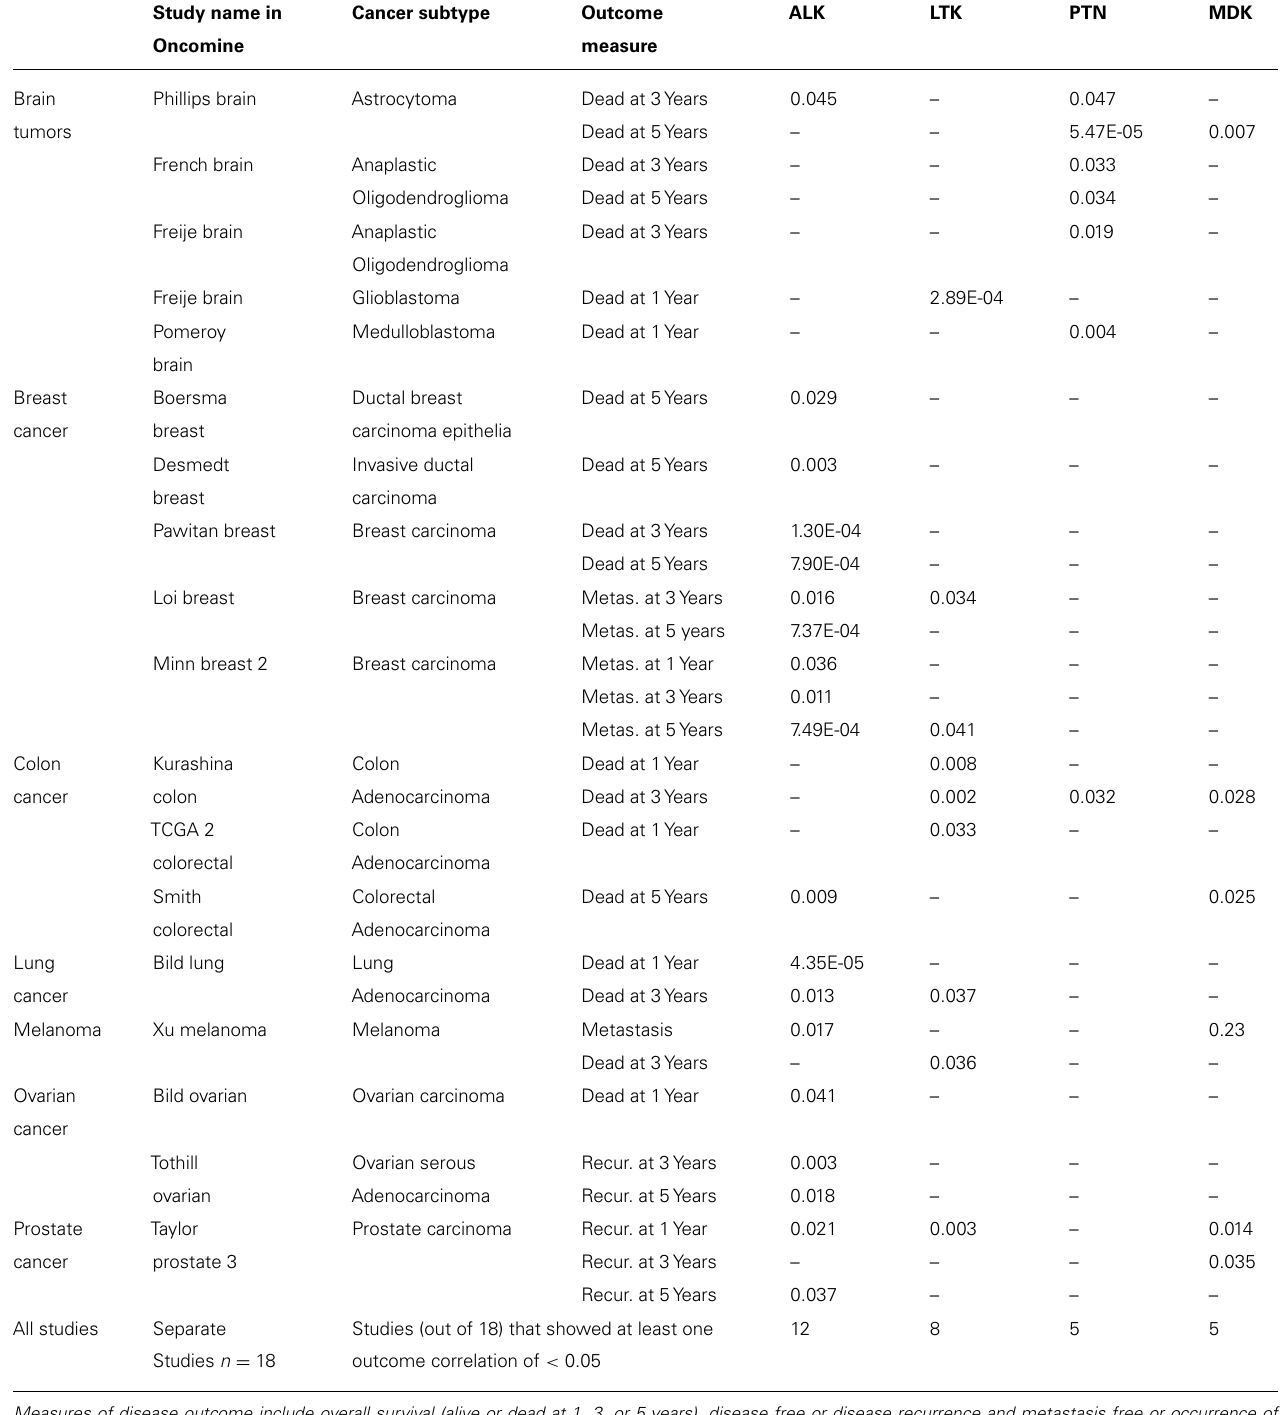
Table 2 | Disease outcomes relative to gene expression ofALK, LTK, PTN, and MK in clinical cancer